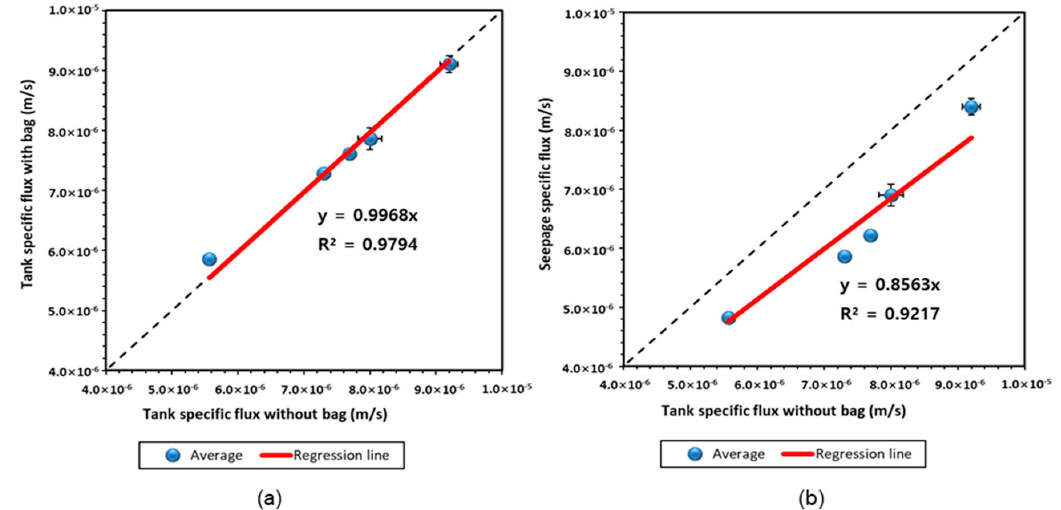
Figure 5. Comparison of ( a ) the tank specific influx rates with and without the collection bag and ( b ) the tank specific influx rate and the seepage specific influx rate measured using the Type 2 collection bag. Error bars represent the standard deviations for five to eight experiments at each head difference (see Table 3).